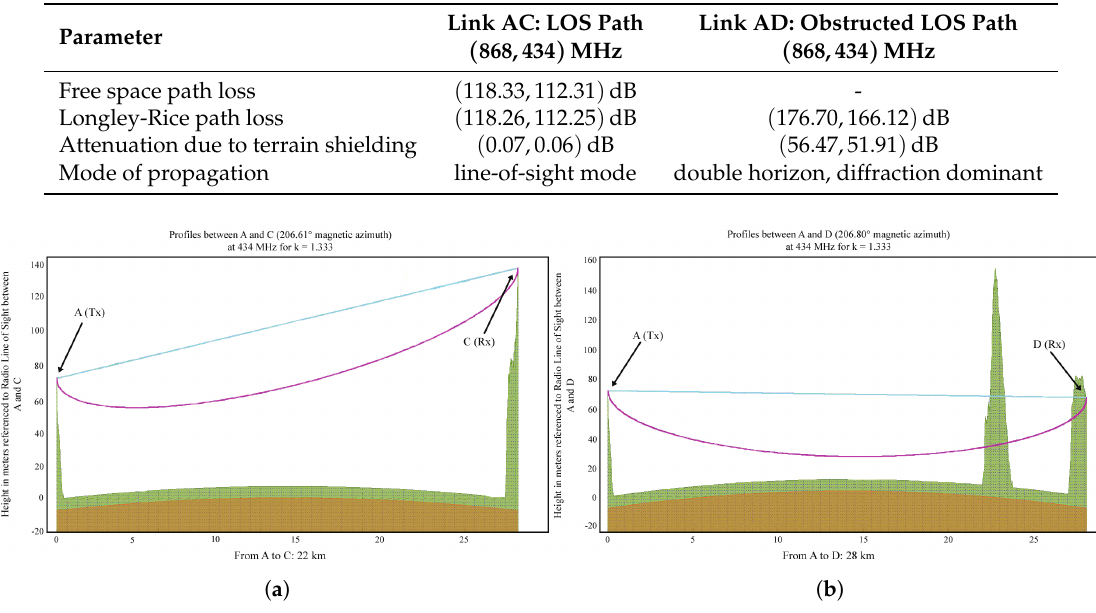
Figure 5. Terrain profiles for: ( a ) Line-of-Sight path over sea. ( b ) Obstructed path over sea. Brown area indicates the curvature of the earth, modified by the refraction index; Green area is the terrain profile as seen by the radio wave and magenta line corresponds to 60% of the first Fresnel zone at 434MHz; and blue line is the optical line of